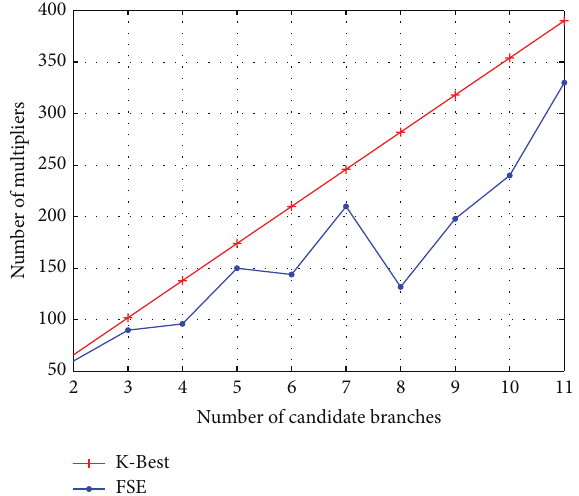
Figure 6: Number of required multipliers for the K -best and FSE tree-search techniques as a function of the number of candidate branches.